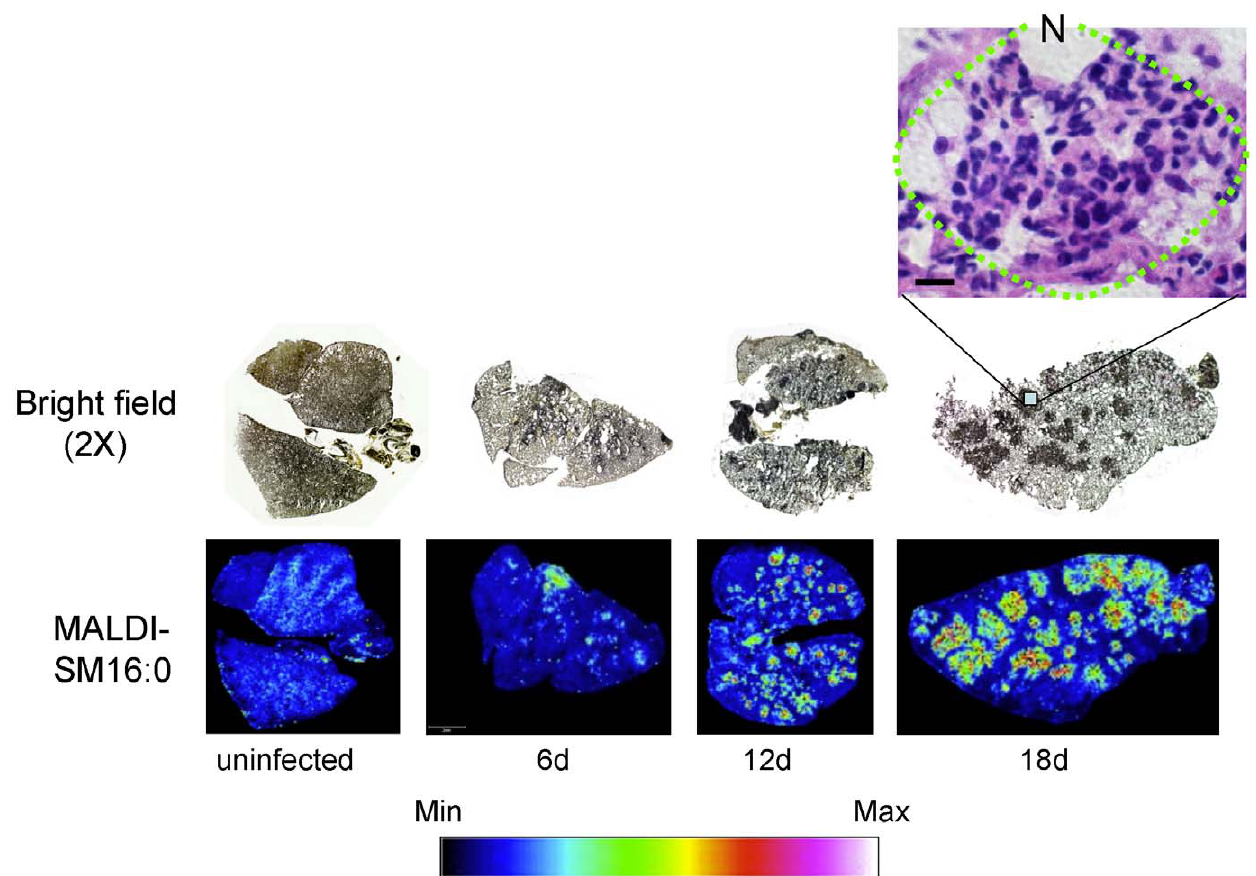
Figure 8. Matrix-assisted laser desorption-ionization mass spectrometry (MALDI-MS) of SM C16:0 in lung infected with C. neoformans . Lungs of CBA/J uninfected and infected mice with C. neoformans wild-type H99 strain were processed for MALDI tissue imaging and bright field photograph (2X) of a lung section stained with mucicarmine. Sphingomyelin (SM) 16:0 species ([M + Na] + m/z 725) is concentrated in areas highly infiltrated with neutrophils, especially at 18 days of infection, as showed by hematoxylin and eosin staining at right. Min and Max, minimum and maximum intensity, respectively. N, neutrophils in dotted circle; black bar, 20 m m.